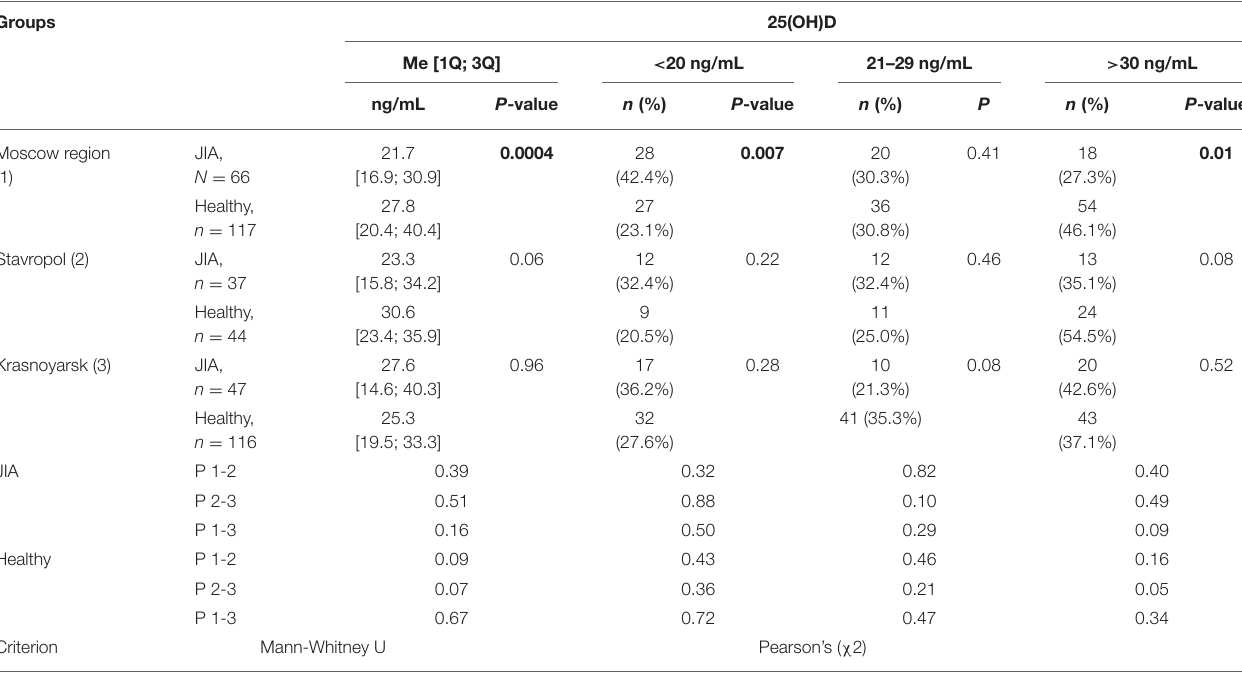
TABLE 5A | Distribution of calcidiol (25(OH)D) level within each group according to each geographical region.